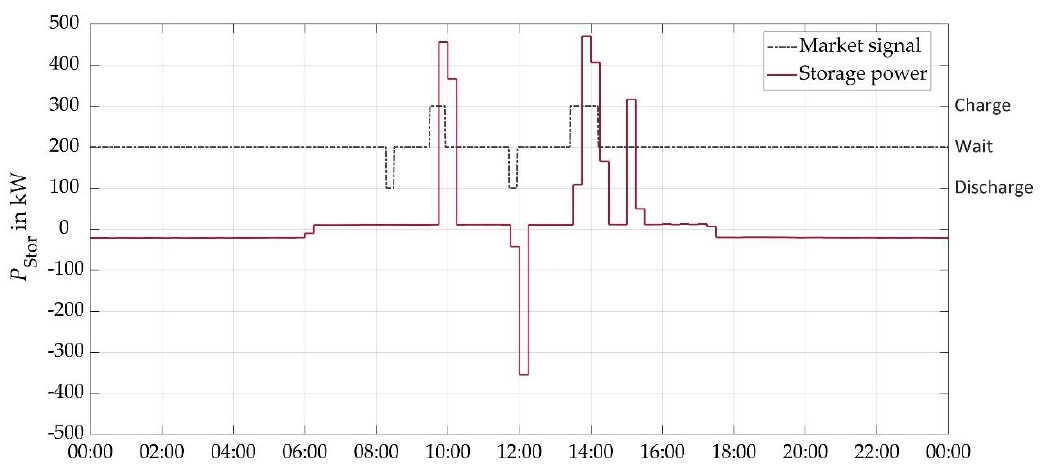
Figure 12. Battery storage system operation using energy market information (2 March 2016).